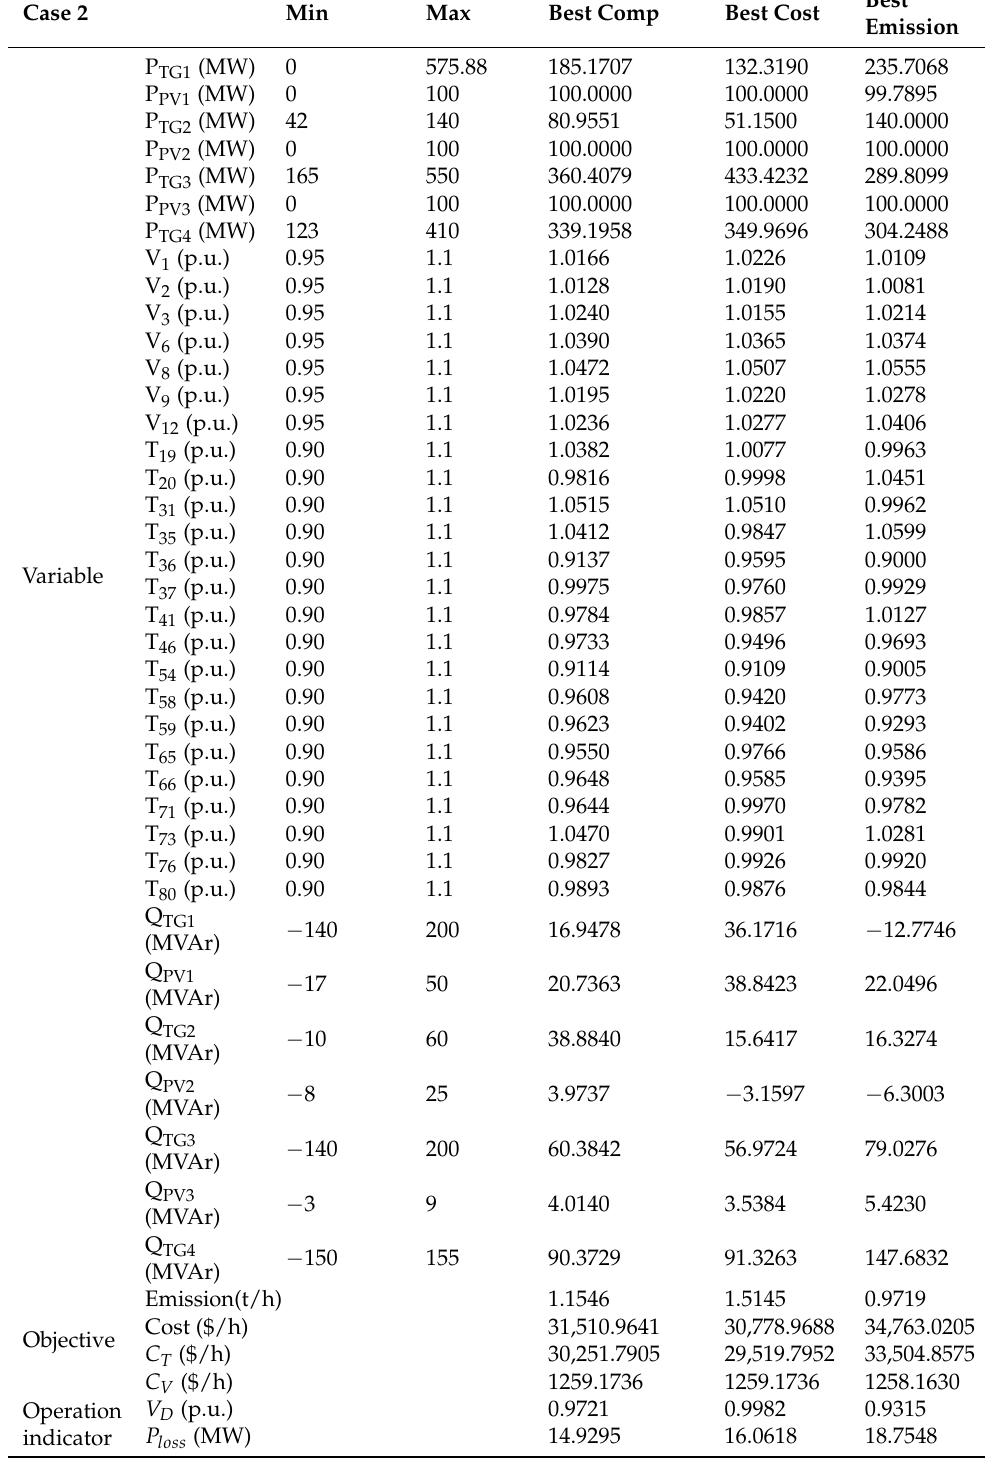
Table A2. Best solutions offered by CMODE in case